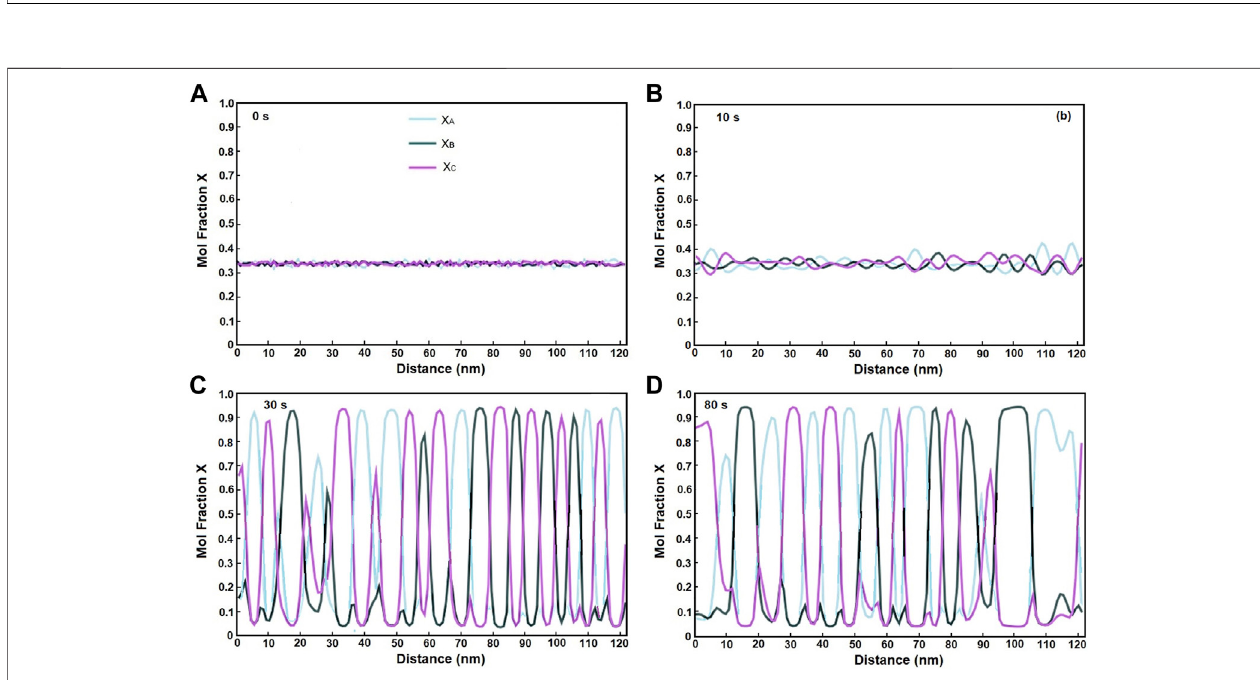
FIGURE 5 | Simulated concentration pro fi les of the A – B – C alloy for case I with X A = X B = X c = ⅓ aged at 800 K for (A) 0 s, (B) 10 s, (C) 30 s, and (D) 80 s.